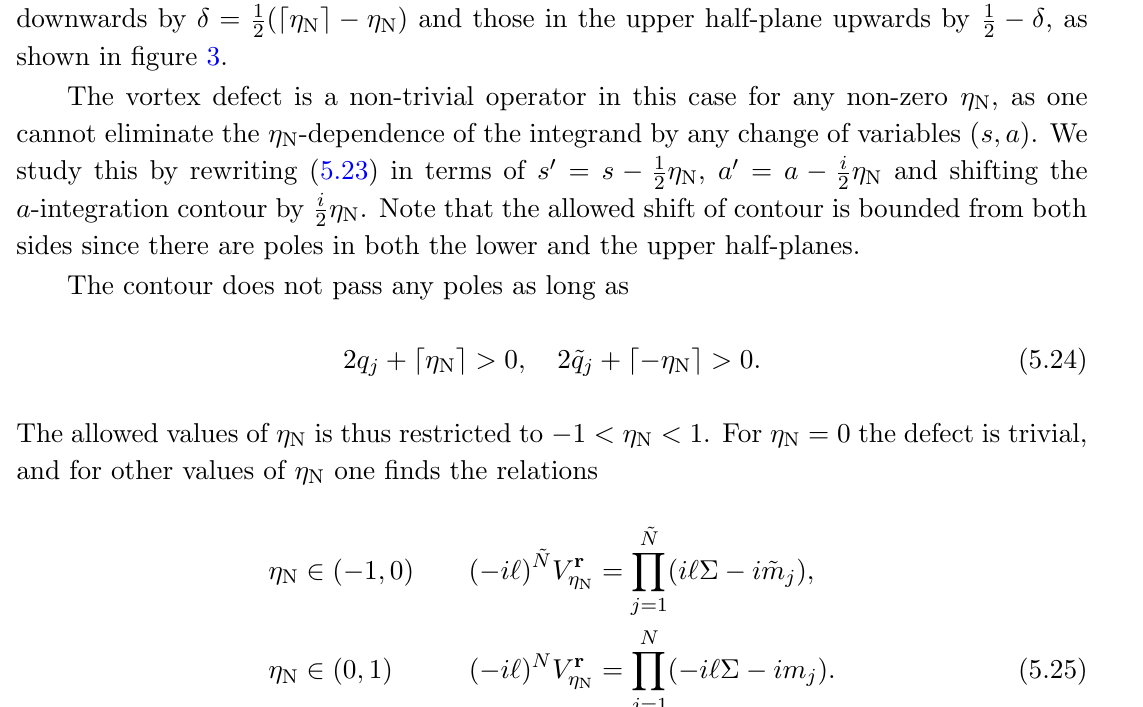
(cid:0) (cid:14) , as 2